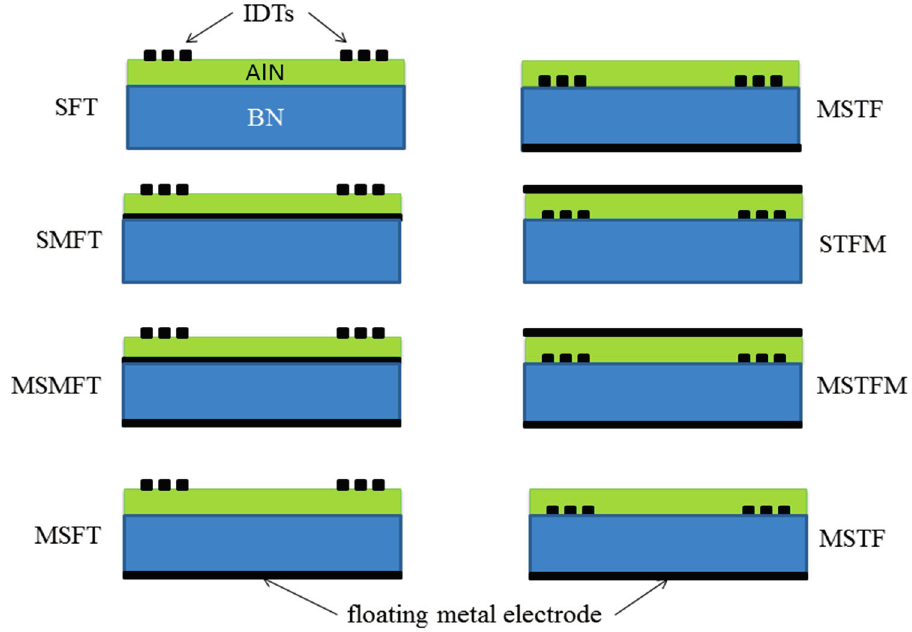
Figure 5. Cross-sections of the eight coupling configurations: the green, blue and black layers refer to the AlN (F, film), BN (S, substrate) and metal films (M, metal); the IDTs (T, transducers) are also